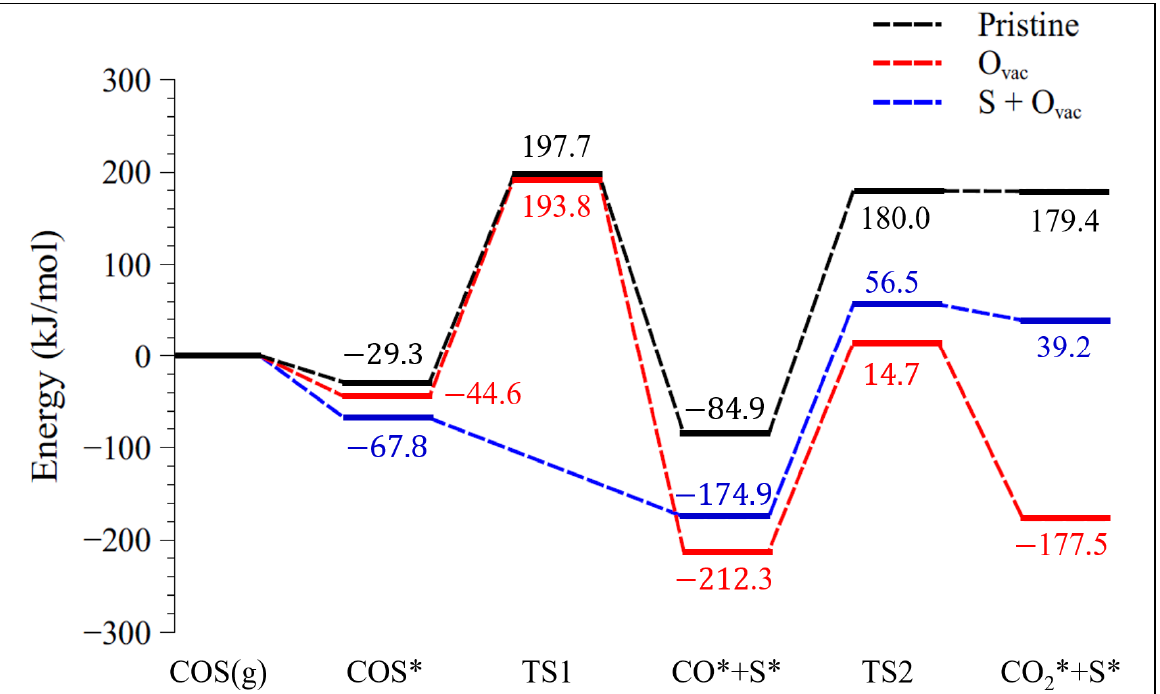
Figure 12. DFT evaluated COS oxidation reactions toward CO 2 on CuO(111) with and without the oxygen vacancies and a surface sulfur atom. The black, red, and blue lines are the reactions on pristine CuO(111), oxygen vacant employed CuO(111), and both surface sulfur atom and oxygen vacancy introduced CuO(111), respectively. TS stands for transition state.